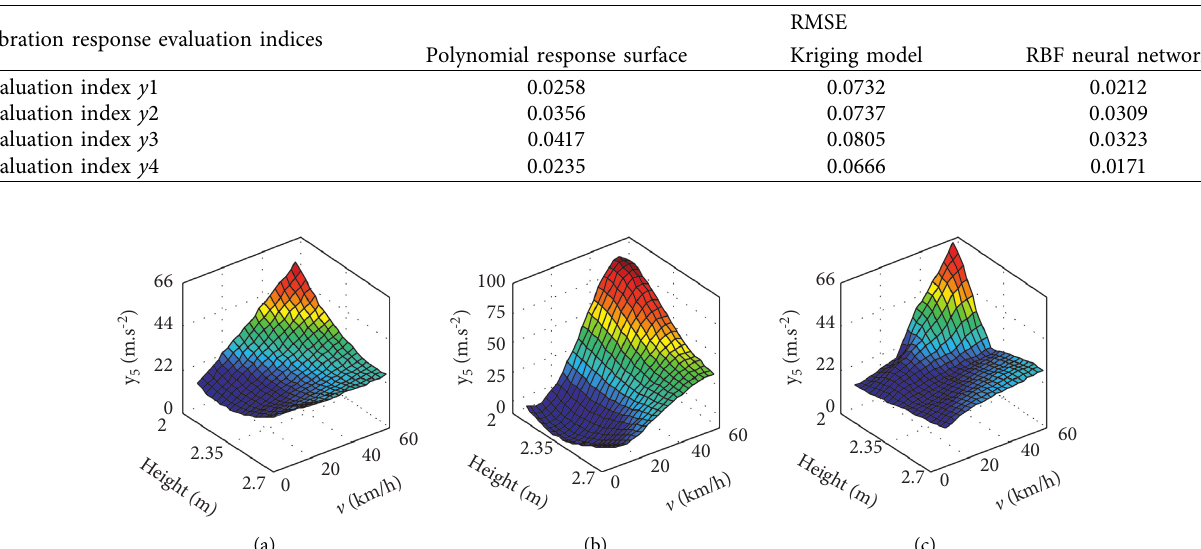
Table 15: RMSE of approximate model.